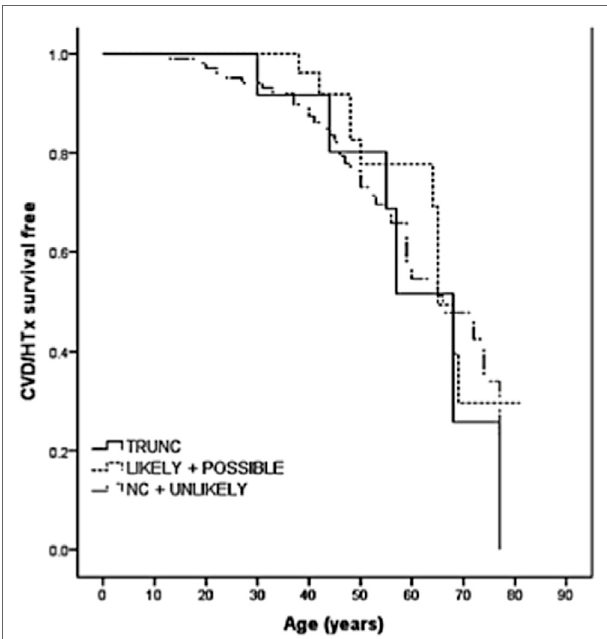
FiGURe 3 | Long-term survival curves in TTN variant carriers . Kaplan–Meier event-free survival for cardiovascular death (CVD) or heart transplantation (HTx) based on TTN variant categories: truncations (TRUNC); “likely” and “possibly” missense variants; non-carriers (NC), and “unlikely” with lack of cosegregation. TTN indicates titin gene (from Begay et al., with permission)